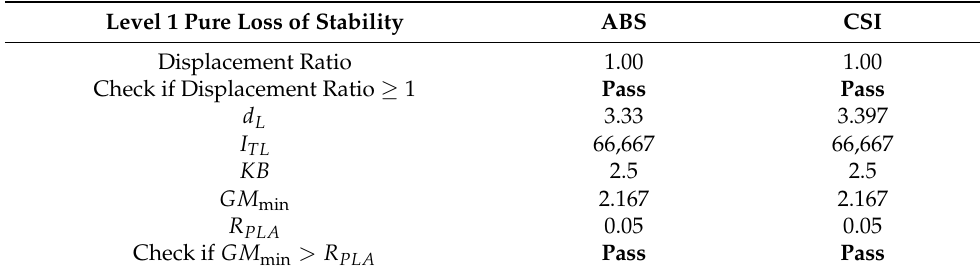
Table 9. Level 1 assessment of the pure loss of stability failure mode for the barge.